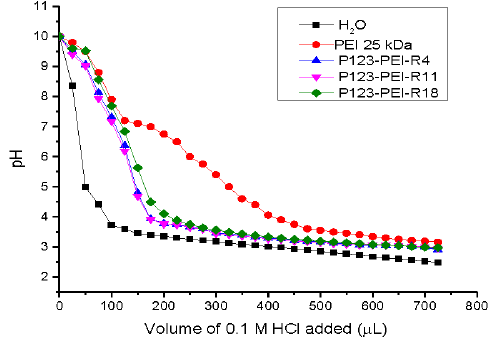
Figure 2. Determination of the buffering capacity of PEI 25 kDa, P123-PEI-R4, P123-PEI-R11 and